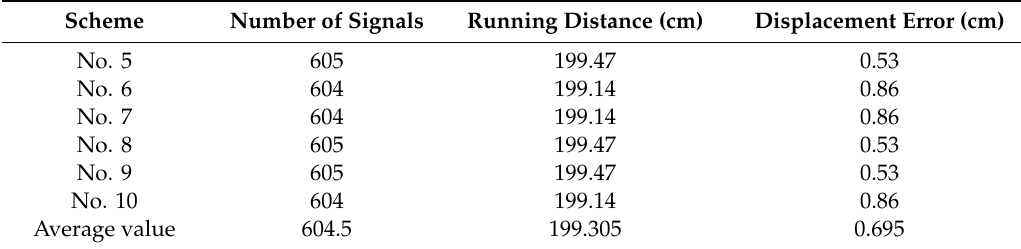
Table 5. Pulse data output from the Hall sensor.